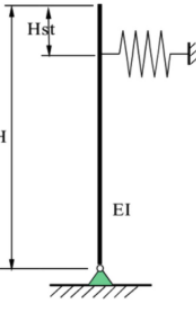
Figure 9. Equivalent model of subsea wellhead. [This figure was modified with permission from ref [149]. Copyright 2020, Elsevier].